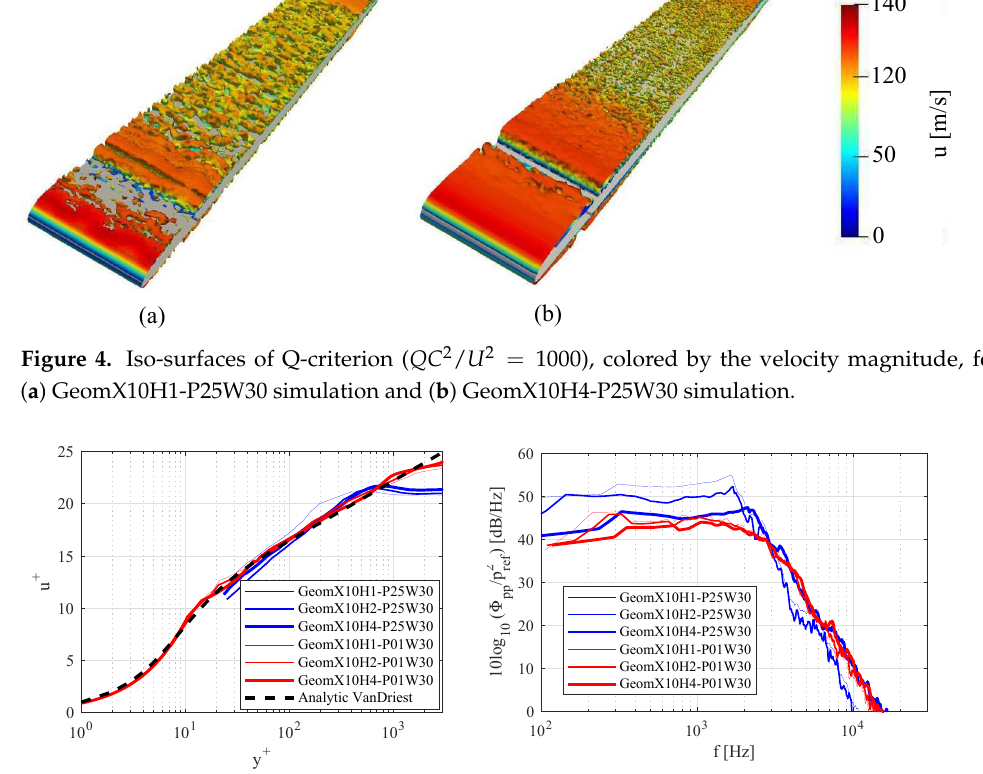
Figure 5. Comparison of the mean velocity profiles ( left ) and WPS in the vicinity of the trailing edge ( right ) between LES simulations using different trip